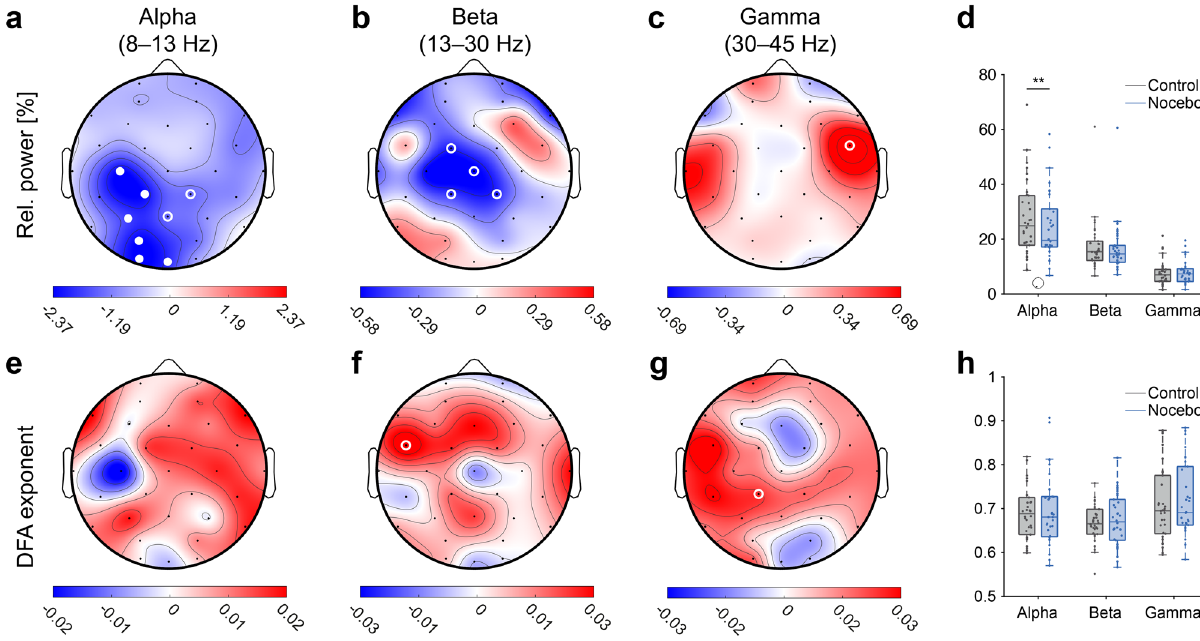
Figure 3. Oscillatory power of alpha oscillations is suppressed during conditioning of nocebo hyperalgesia. ( a – c ) Difference in relative power alpha ( a ), beta ( b ) and gamma band ( c ) for nocebo minus control trials , mean of all subjects. Differences were tested for statistical significance using the non-parametric paired Wilcoxon signed-rank test. Open white circles show statistical significance at P < .05. Closed white circles indicate significance after correcting for multiple comparisons using a False Discovery Rate procedure (FDR) with q = 0.05, per topography. ( d ) Boxplots for relative power alpha, beta and gamma band. ( e – g ) Difference in DFA ( h ), beta ( i ) and gamma band ( j ) for nocebo minus control trials , mean of all subjects. ( h ) Boxplots for DFA alpha, beta and gamma band. All boxplots show the mean of all channels, except for relative power alpha in ( g ), where the boxplots show values of electrode PO3. Electrode PO3 was chosen as a representative electrode, since the significant differences were spatially localized above parietal and occipital